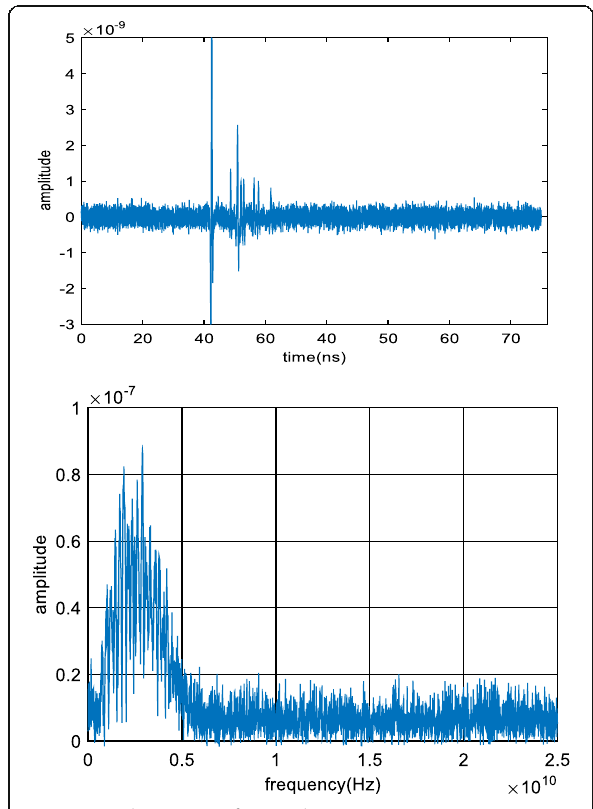
Fig. 4 Time domain waveform and energy spectrum with E b / N 0 =40